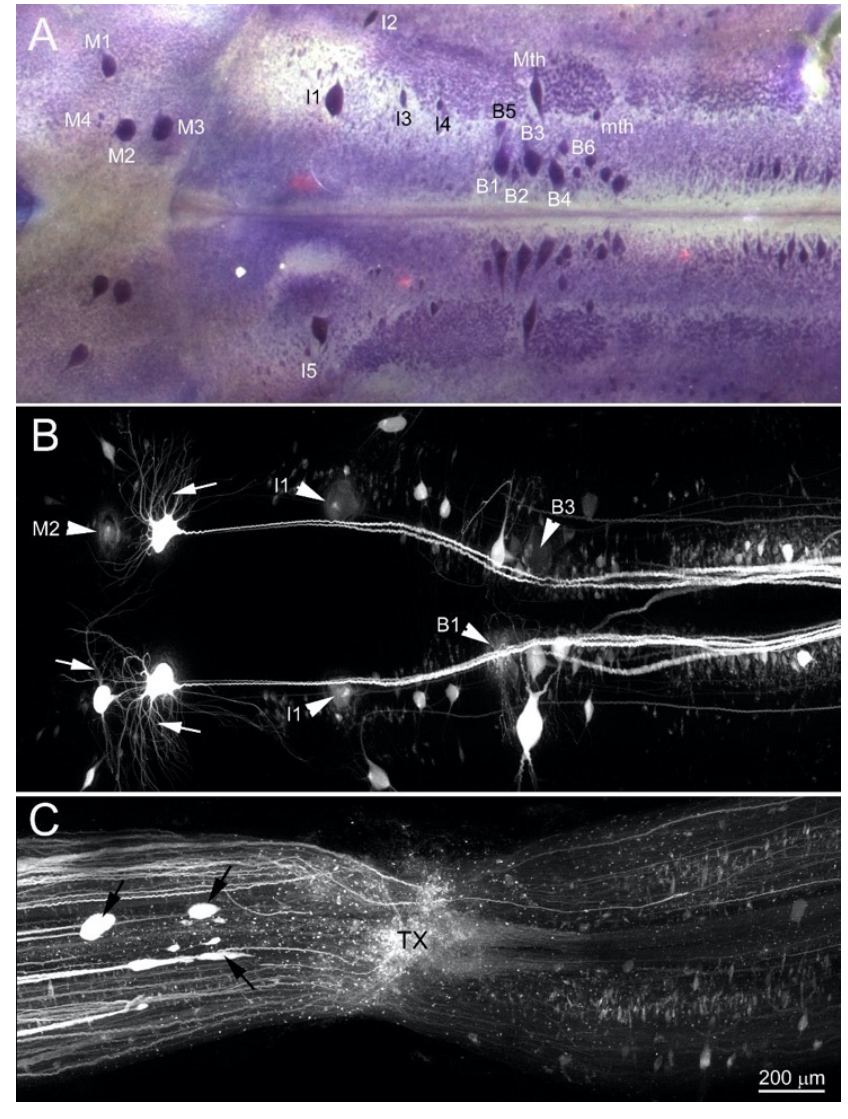
Figure 4. High structural resolution of early degenerative changes in back-labeled neurons and axons after BABB clearing. ( A ) toluidine blue-stained wholemount of a control lamprey brain, showing the large identified RS neurons. ( B – C ) RS neurons were labeled retrogradely by application of DTMR to a fresh SC TX at the level of the 5th gill. After 4 weeks recovery, the brain and SC spanning the TX site were removed, fixed and cleared in BABB. ( B ) a wholemount of the brain shows all the RS neurons that project as far as the lesion, including detailed dendritic structures, as seen in focus for neuron M 3 bilaterally (arrows), as well as numerous small neurons, which could not be seen before clearing. Some swollen RS neurons with faint fluorescent labeling (arrowheads) are undergoing early stage apoptosis, which causes dye to leak out of the cell. ( C ) an image of the SC at the lesion site shows many axons regenerating to, and even beyond, the TX site (rostral is left). White arrows indicate bulbous growing axon tips. The calibration bar in ( C ) is for all three